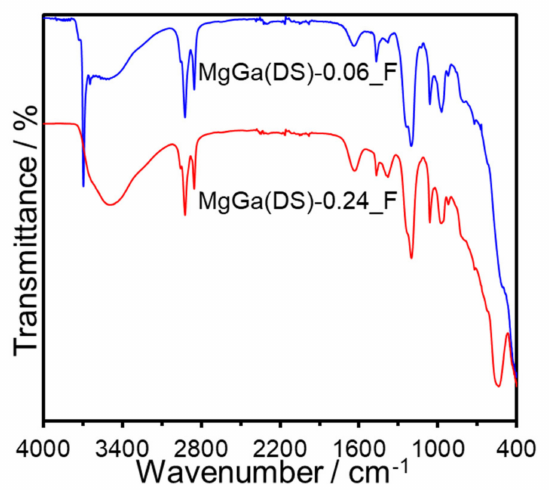
Figure 8. XRD patterns of MgGa(CO 3 )-x_F (a), calcined MgGa(CO 3 )-x_F (b), and MgGa(DS)-x_F (c); x of 0.24 ( A ) and 0.06 ( B ). Inset: the (003) reflection of MgGa(DS)-0.24_F at 2 θ of 3 ◦ .